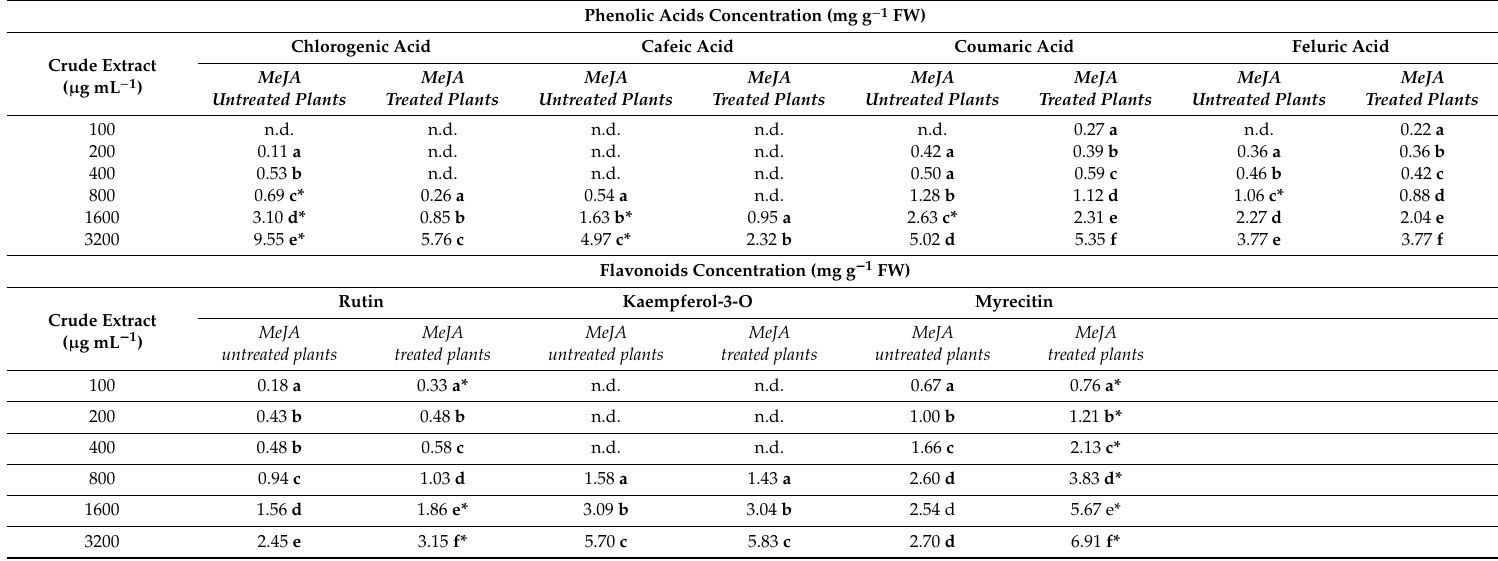
Table 3. Phenolic acid and flavonoid composition (analyzed by HPLC-DAD) of leaves aqueous extracts from blueberry plants untreated and treated with